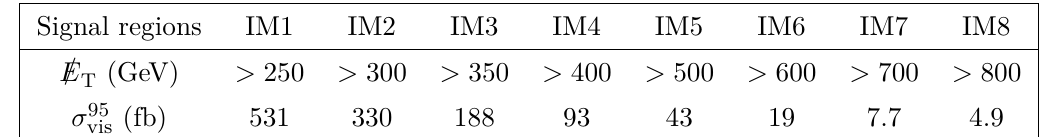
√ analysis at s = 13 TeV [83]. σ 95 is the T vis